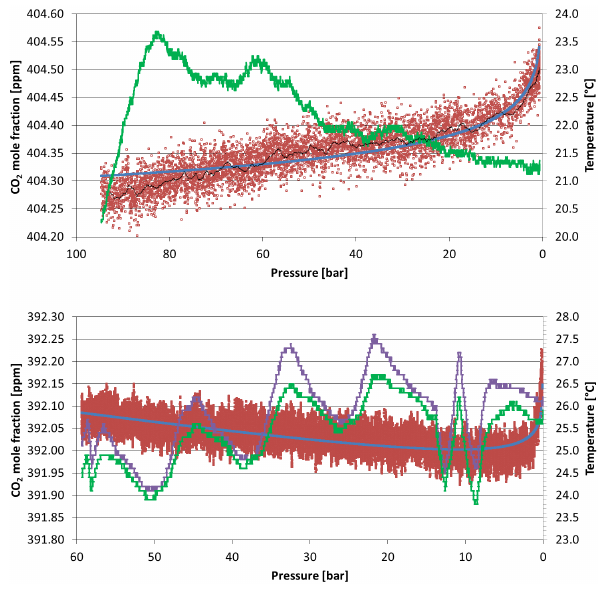
Figure 4. Fast- and slow-emptying experiment within 8h (upper panel) and 120h (lower panel), respectively: CO 2 mole fraction of an aluminium cylinder vs. its pressure in red (5s resolution). The Langmuir monomolecular layer desorption model is shown in blue (CO 2 , ad = 0.047ppm, K = 0.001bar − 1 ) for a decanting rate of 5Lmin − 1 in the upper panel and for 0.25Lmin − 1 in the lower panel (CO 2 , ad = 0.028ppm, K = 0.001 bar − 1 ) . Temperature evo- lution corresponding to the pressure evolution is displayed for the aluminium cylinder (green line) and for the pressure regulator (in violet). Note that the decreasing trend can be explained by the Joule- Thompson cooling effect and has nothing to do with the adsorption theory. The desorption energies could not be determined with con- fidence during these decanting